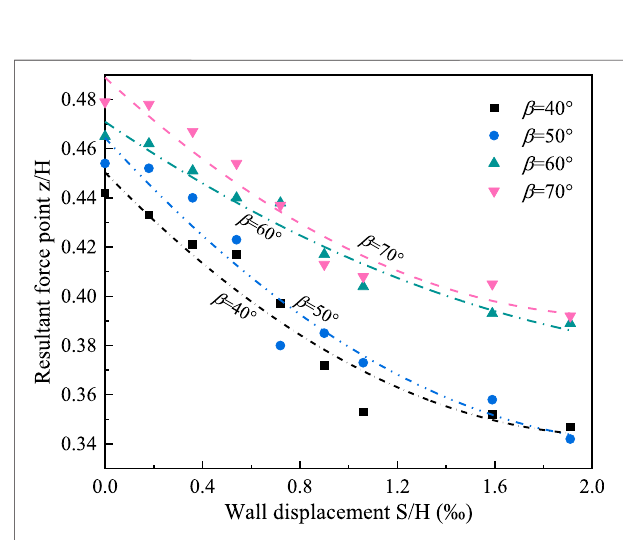
FIGURE 7 | Change of height of Resultant force point with wall displacement in T